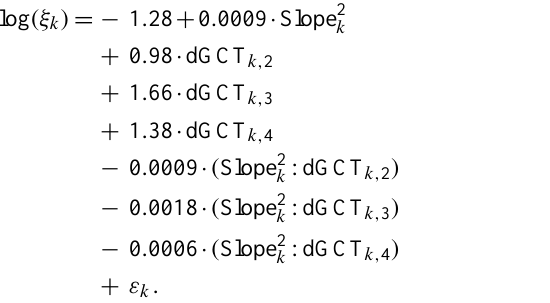
Fig. 7. Scatterplot of measured and modelled MAGST of Model (3). The dashed red line indicates the diagonal y = x . The model ex- plains 93% of the variability of measured MAGST.